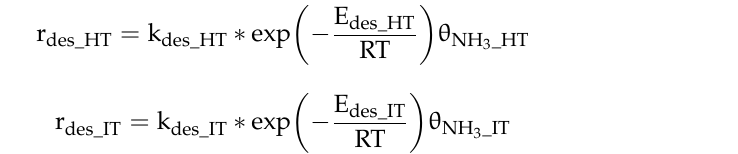
Figure 10. The relationship of the NH 3 desorption rate and temperature for the IT peak.